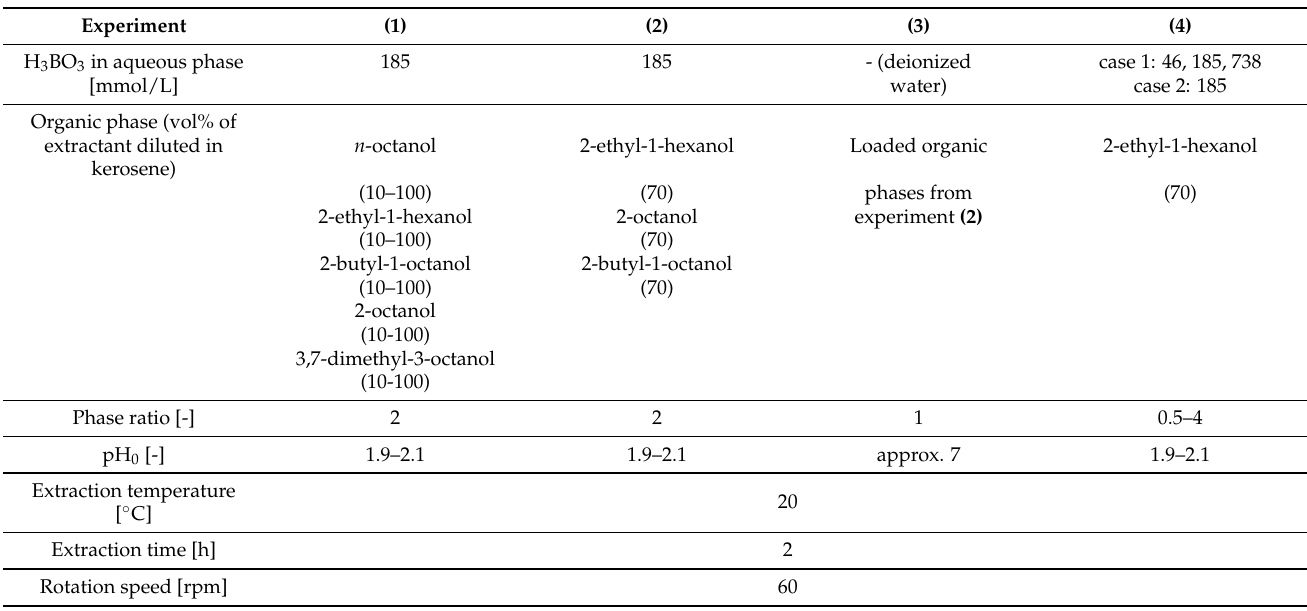
Table 1. Experimental conditions for extraction experiments: (1) effect of alcohol (ROH) concentration on distribution ratio, (2) effect on ionic strength on distribution ratio, (3) co-extraction of salting-out agent, (4) determination of equilibrium relationship.